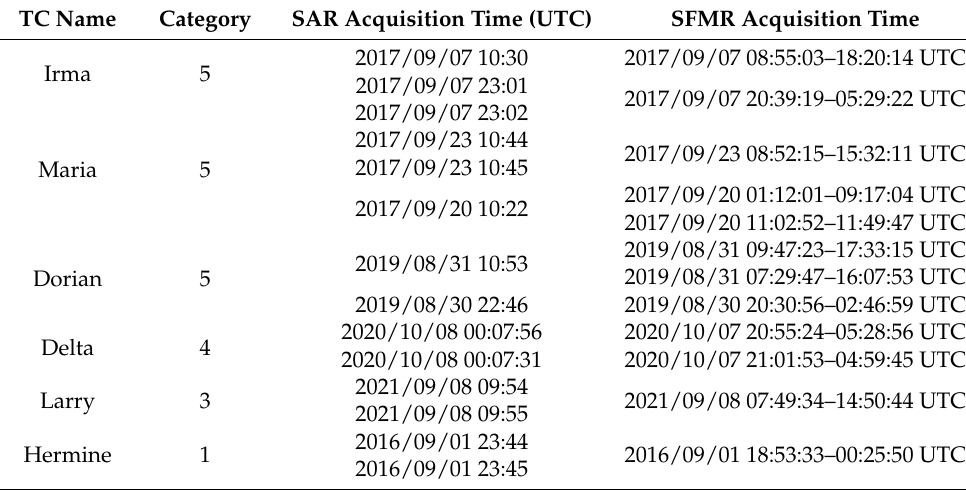
Table 1. List of selected TCs, Sentinel-1 and SFMR acquisition